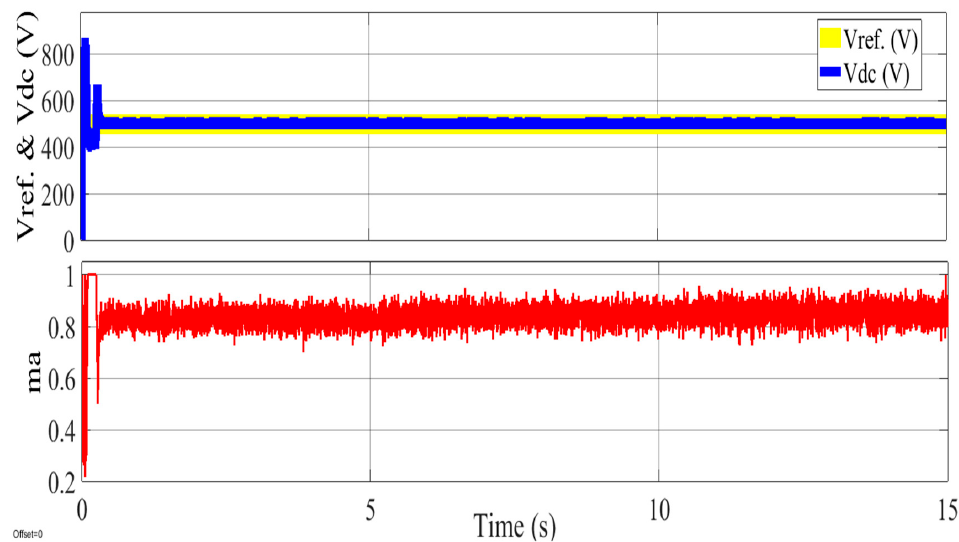
Figure 12. The DC-link voltage of the IBC and the modulation index (ma) of the inverter.